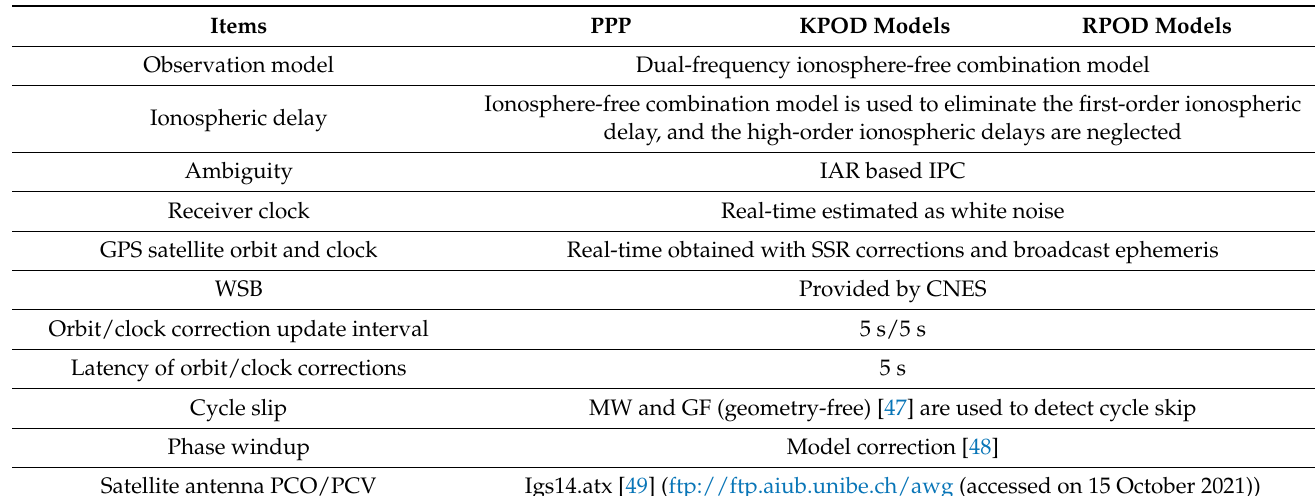
Figure 1. Flow chart of ambiguity resolution for real-time PPP/LEO POD. Table 1. Processing strategy of real-time PPP, LEO KPOD, and